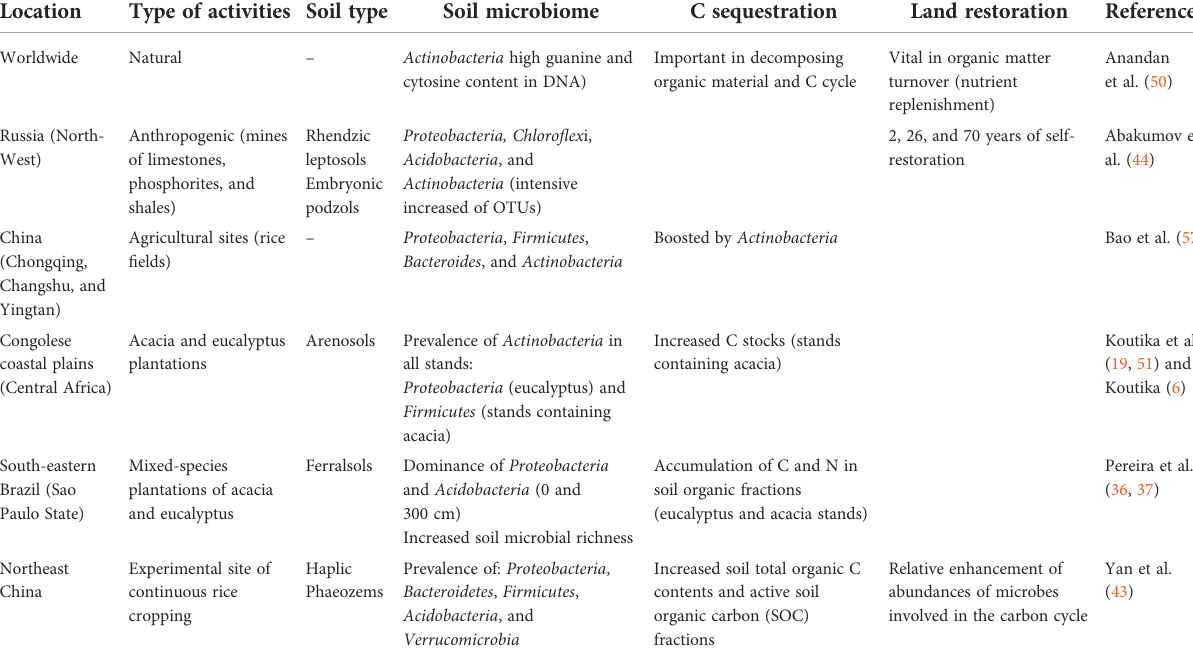
TABLE 1 Effects of different activities on soil microbiome, soil C sequestration, and land restoration